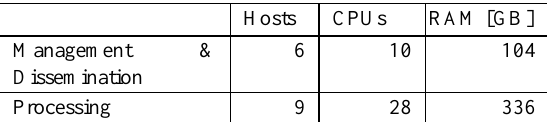
Table 1: Swarm APDF Hardware Summary